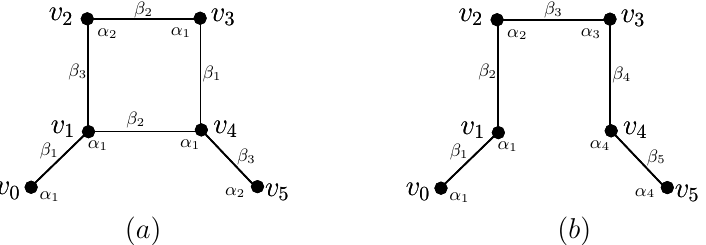
Figure 2. Graphs H and H − v 1 v 4 in Remark 2. A almost sharp example for the upper bound in Theorem